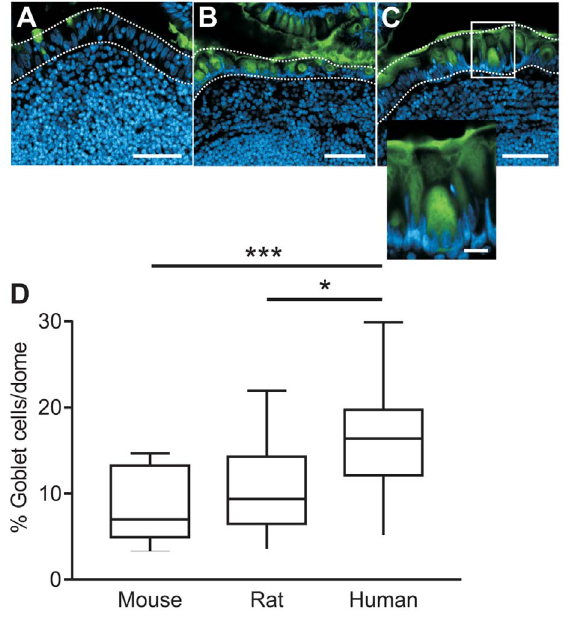
Figure 2. MUC2 positive cells on domes of mouse, rat and human Peyer’s patches. Fluorescent staining of Muc2 reveals mucin containing cells in the FAE of a mouse (A), rat (B) and human (C) ileal PP. Bars=50 m m. Inset in panel C shows the MUC2 positive cells at higher magnification (bar=10 m m). Muc2 staining is green, nuclei are blue and FAE is indicated by dashed lines. (D) MUC2 positive cells and nuclei in FAE were counted in sections from 5 mice, 5 rats and 5 humans. Values are presented as median (25 th and 75 th percentile). The percentage of goblet cells was larger in human FAE compared to mouse FAE ( P , 0.001, ***) and rat domes ( P , 0.05, *).